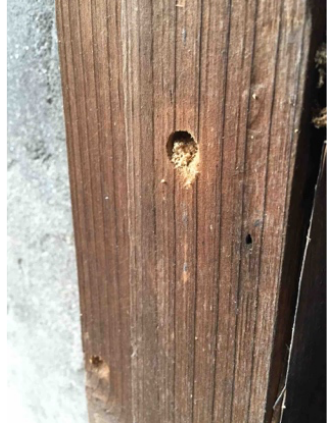
Figure 5 . Timber attacked by wasps